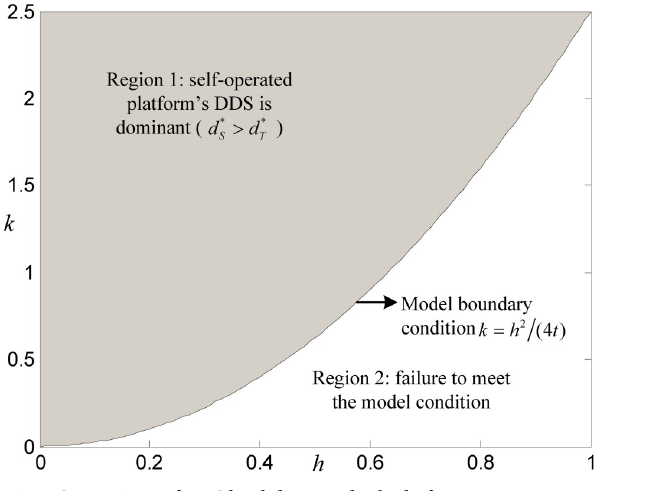
Fig 4. Comparison of DDS levels between both